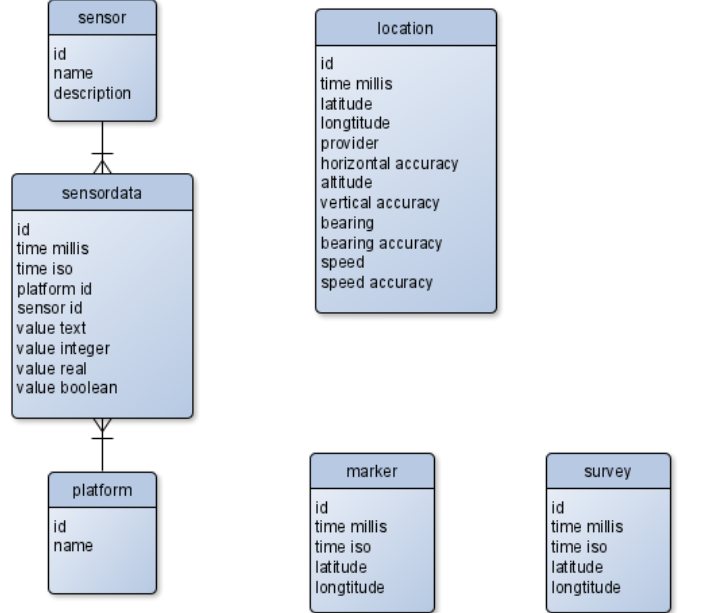
Figure 1. Entity relationship diagram SQLite database.